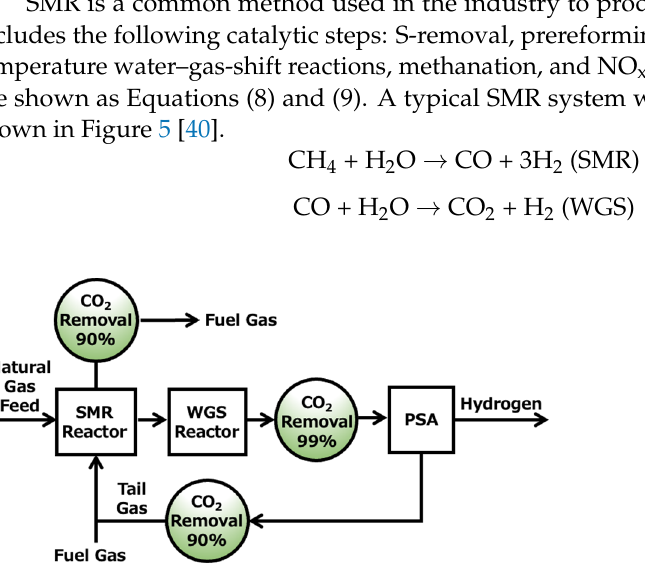
Figure 5. Scheme for a steam methane reforming (SMR) system with CO 2 removal options.